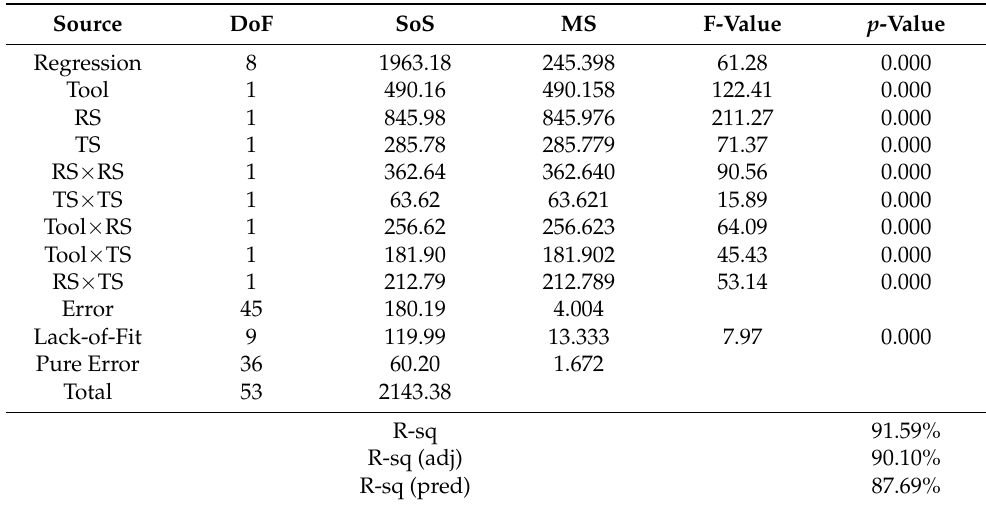
Table 4. Analysis of Variance—ANOVA: sB versus Tool; RS; TS. Source